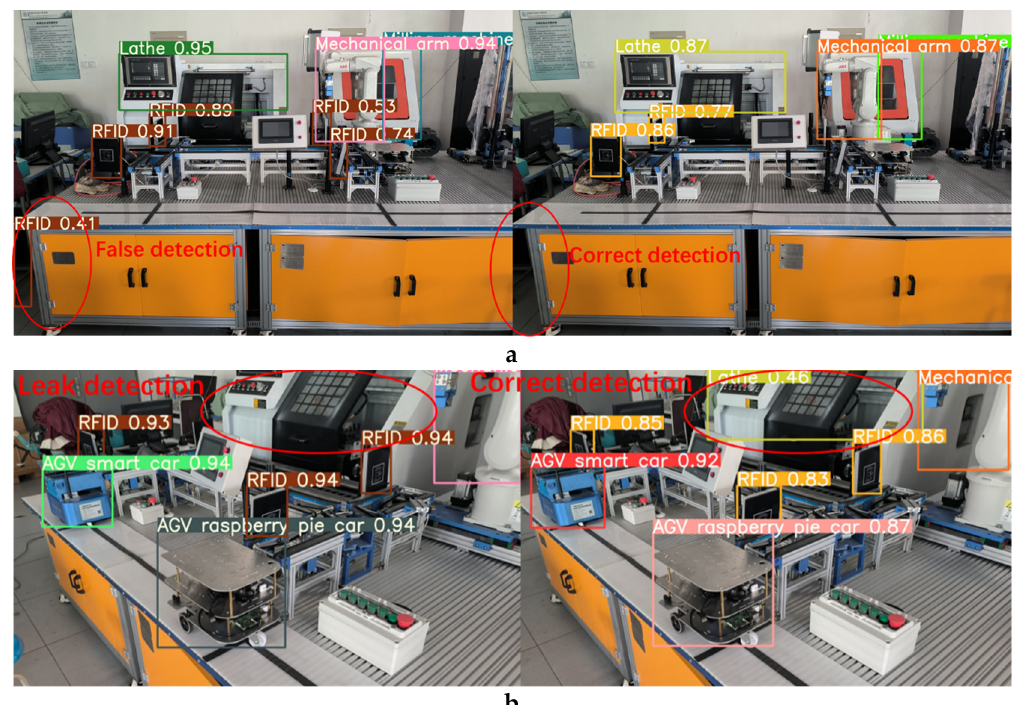
Figure 13. Comparison of recognition test results between YOLOv5-5.0 and the improved method.